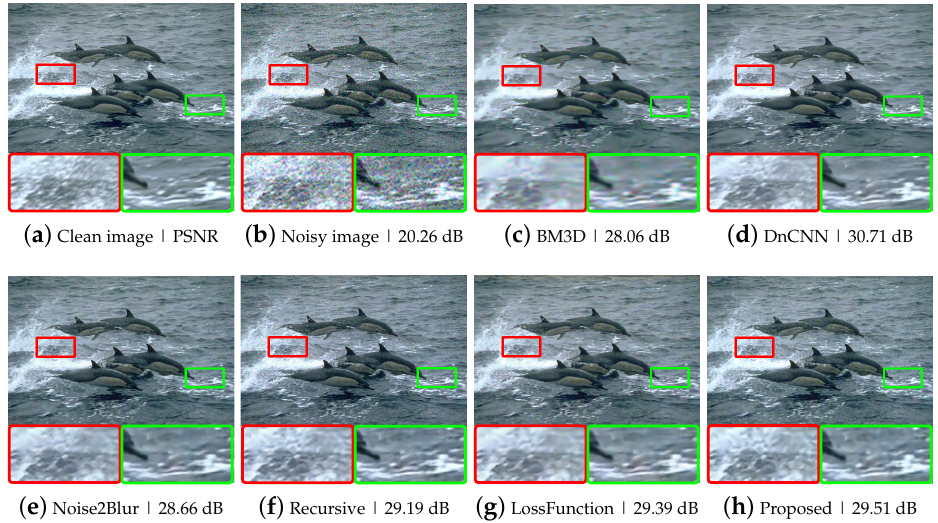
Figure 4. Example images of Gaussian denoising at σ = 25: ( a ) a clean image; ( b ) a Gaussian noisy image; ( c – h ) example images of Gaussian denoising using various noise removal methods. Experiment II tested the denoising ability of the N2BeC method with noisy images at random noise levels between 0 and 50. The simulation results are listed in Table 2 and show a more than 1.05 dB better performance than the N2B model [14]. Figure 5 shows